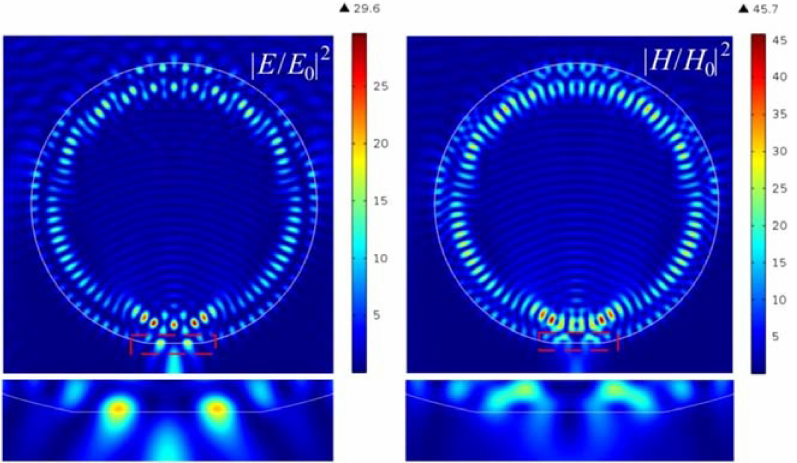
Figure 2. Hot-spot generation in cylindrical Janus particle with parameters h = 42 nm and n = 1.5 (refractive index of the cutting area: n c =